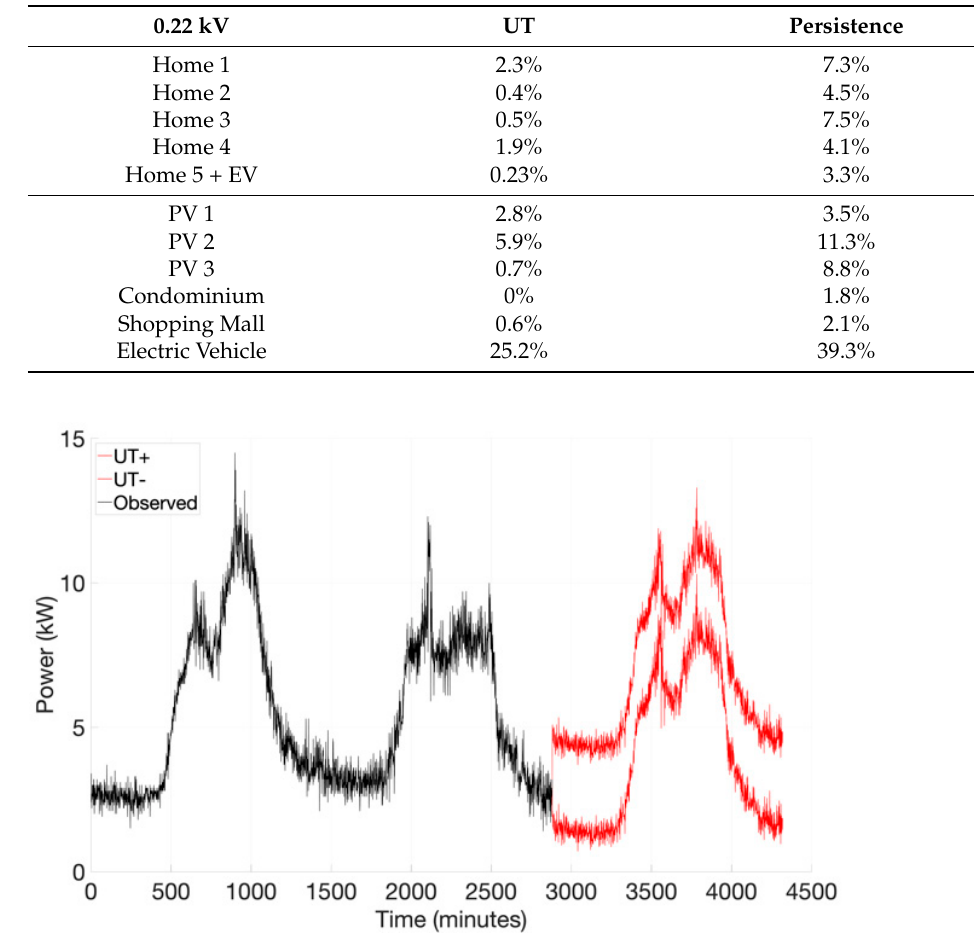
Table 1. Daily Forecast Errors.